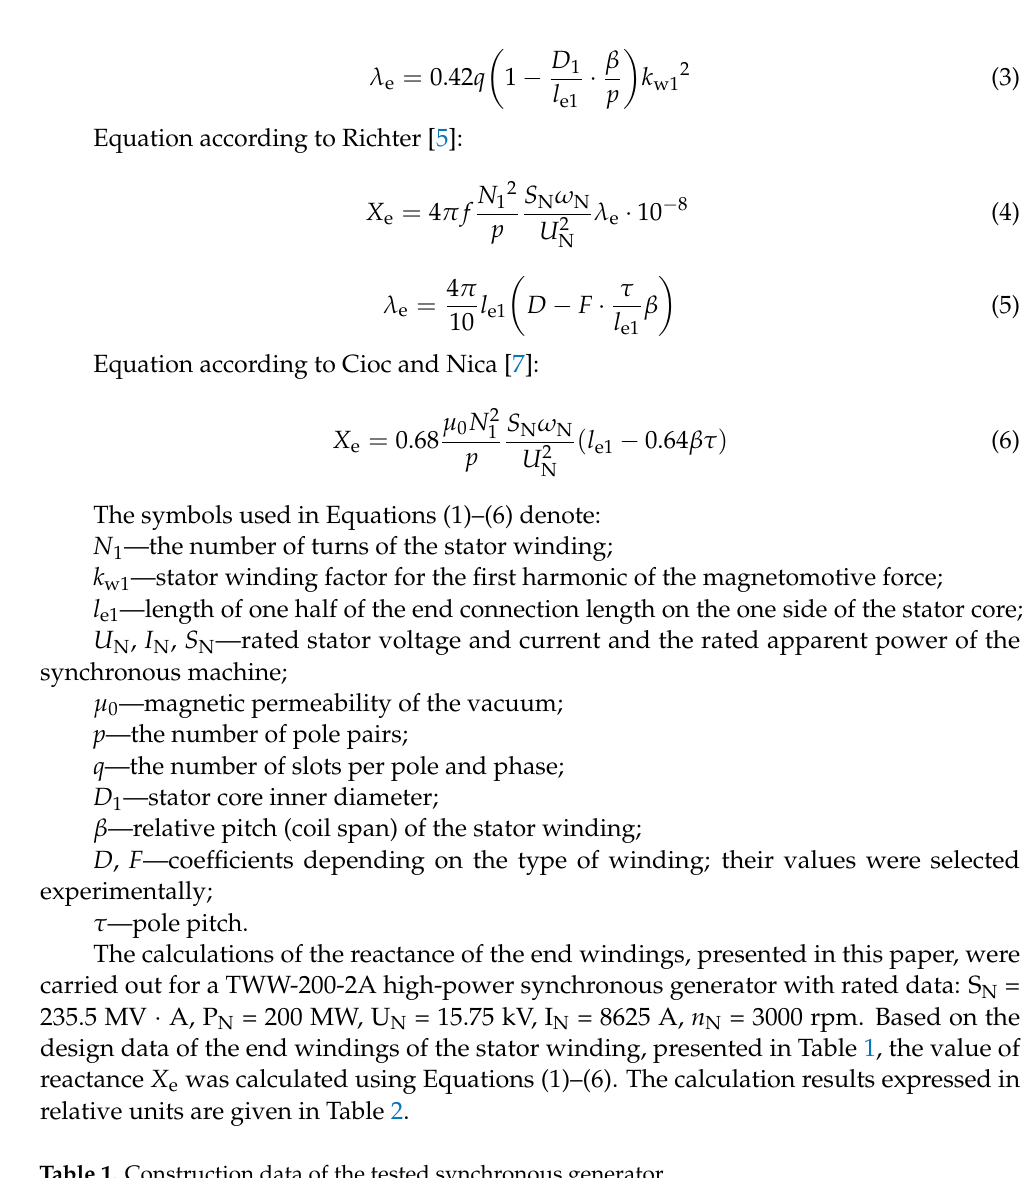
Table 1. Construction data of the tested synchronous generator.